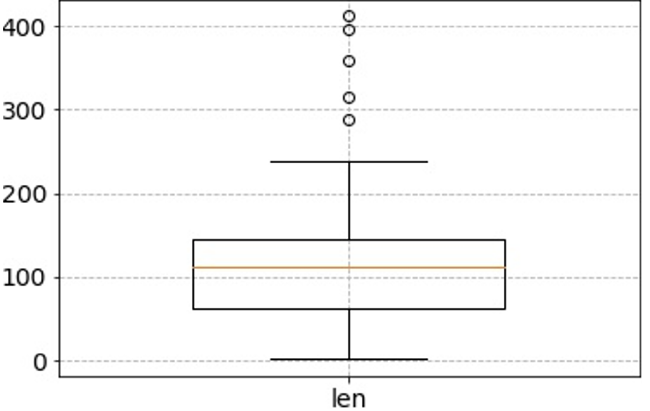
Figure 6. The box-plot of the length distribution.